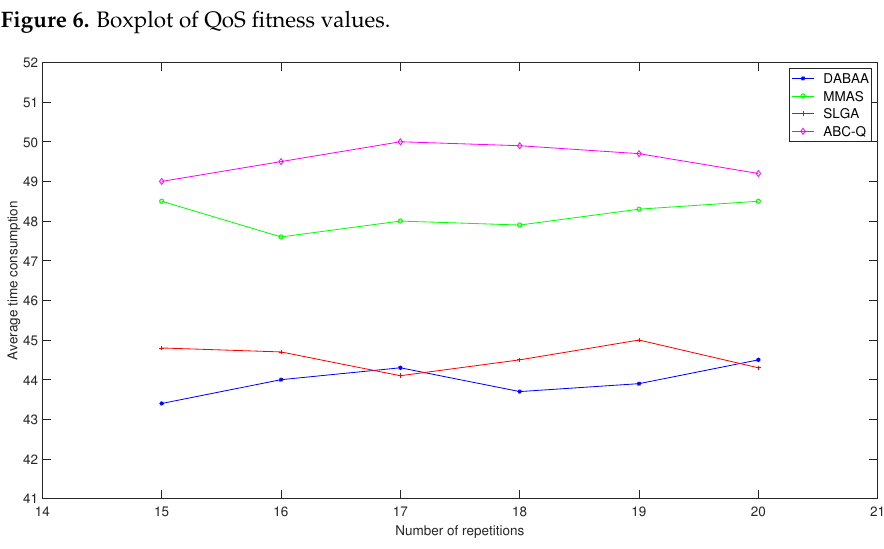
Figure 7. Average time